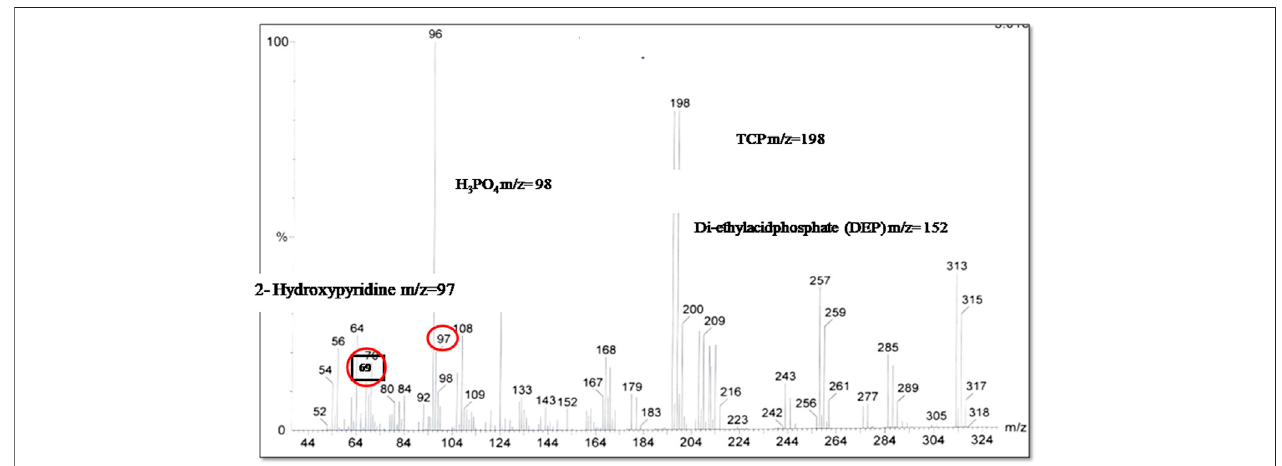
FIGURE 2 | GC-MS chromatograph for wetland with indigenous Canna spps. and Mentha